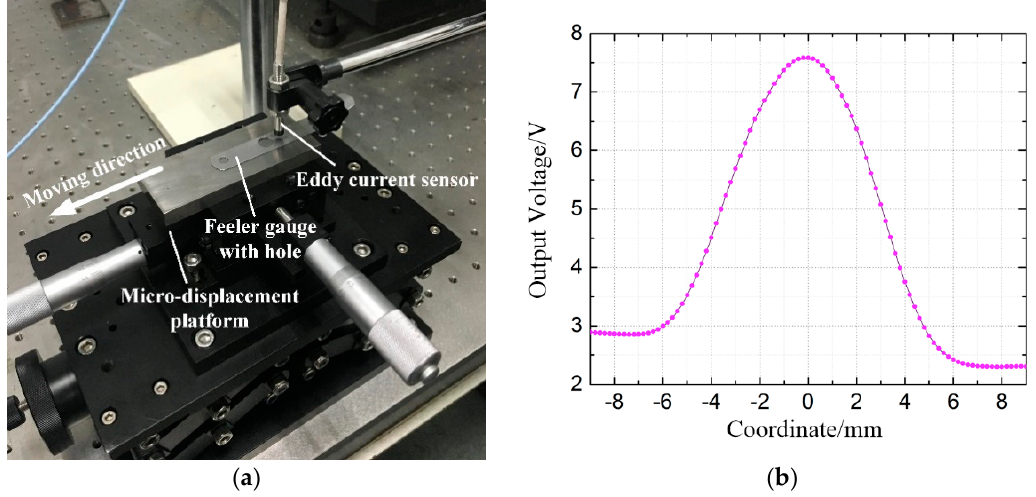
Figure 4. ( a ) Domestic eddy current sensor and ( b ) curve of the data change.